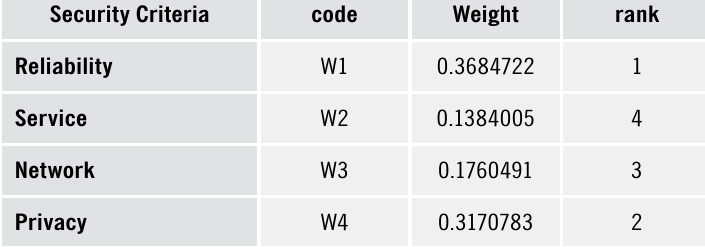
Table 7. Weight of security criteria of IoT supply chain (taken from the fuzzy nonlinear model) Security Criteria